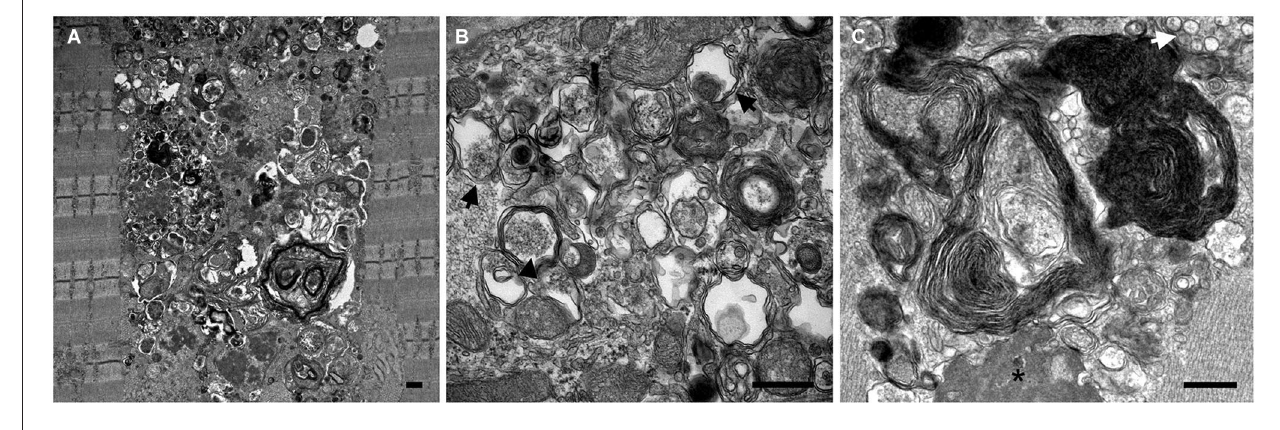
cytosolic material (black arrows) or glycogen particles (arrowhead), multimembrane structures (most prominent in C ), multivesicular body (white arrow), electron dense material (asterisk), as well other cellular debris of unknown origin. Bars: 0.5 µ